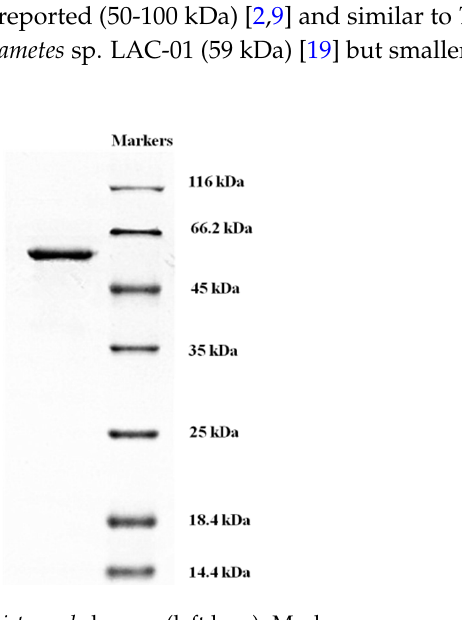
Figure 4. The SDS-PAGE photo of Lepista nuda laccase (left lane). Markers were run on the right lane.